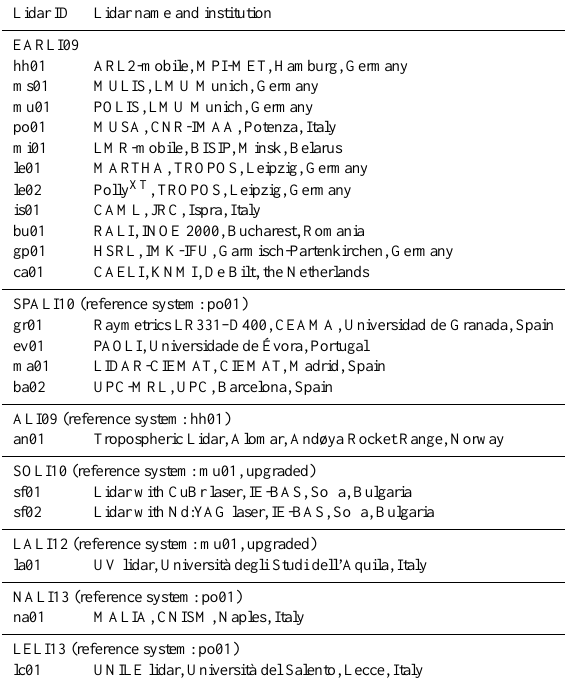
Table 1. EARLINET systems participating in the intercomparison